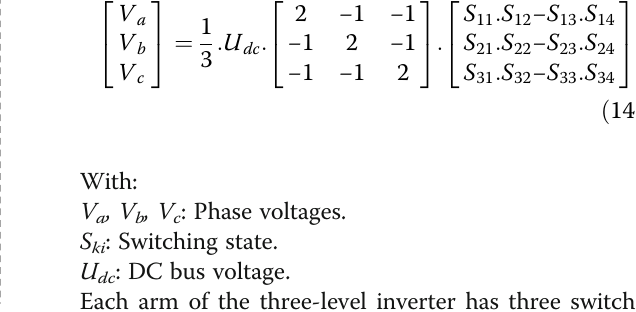
Fig. 4 Voltage vectors of three-level NPC inverter